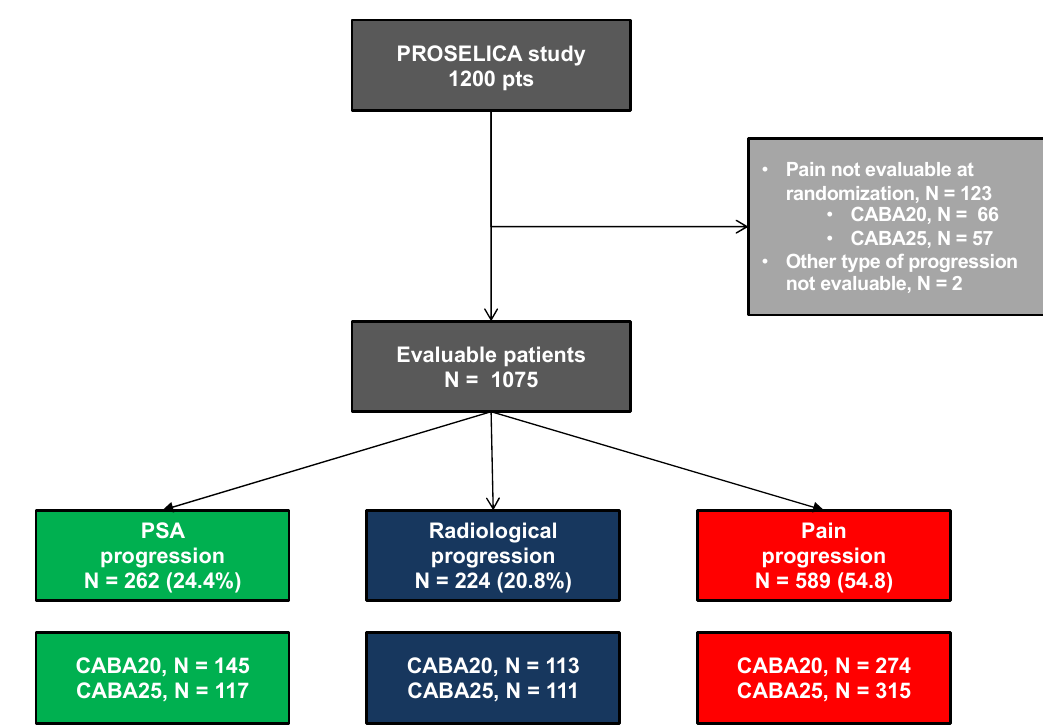
Figure 1. Flow chart. CABA20: cabazitaxel 20 mg/m 2 every 3 weeks (Q3W), CABA25: cabazitaxel 25 mg/m 2 Q3W, PSA progression: patient with a rising PSA only at randomization, Radiological progression: patient with a radiologic progression on CT scan or bone scan with ( N = 177) or without ( N = 47) PSA progression, Pain progression: patient with a mean present pain intensity (PPI) ≥ 2 (McGill–Melzack questionnaire) and/or mean analgesic score (AS) ≥ 10 over the 7 days prior to randomization with ( N = 505) or without ( N = 84) PSA progression or radiological progression. Table 1. Patient characteristics at disease diagnosis and at cabazitaxel initiation by type of disease progression. Characteristic